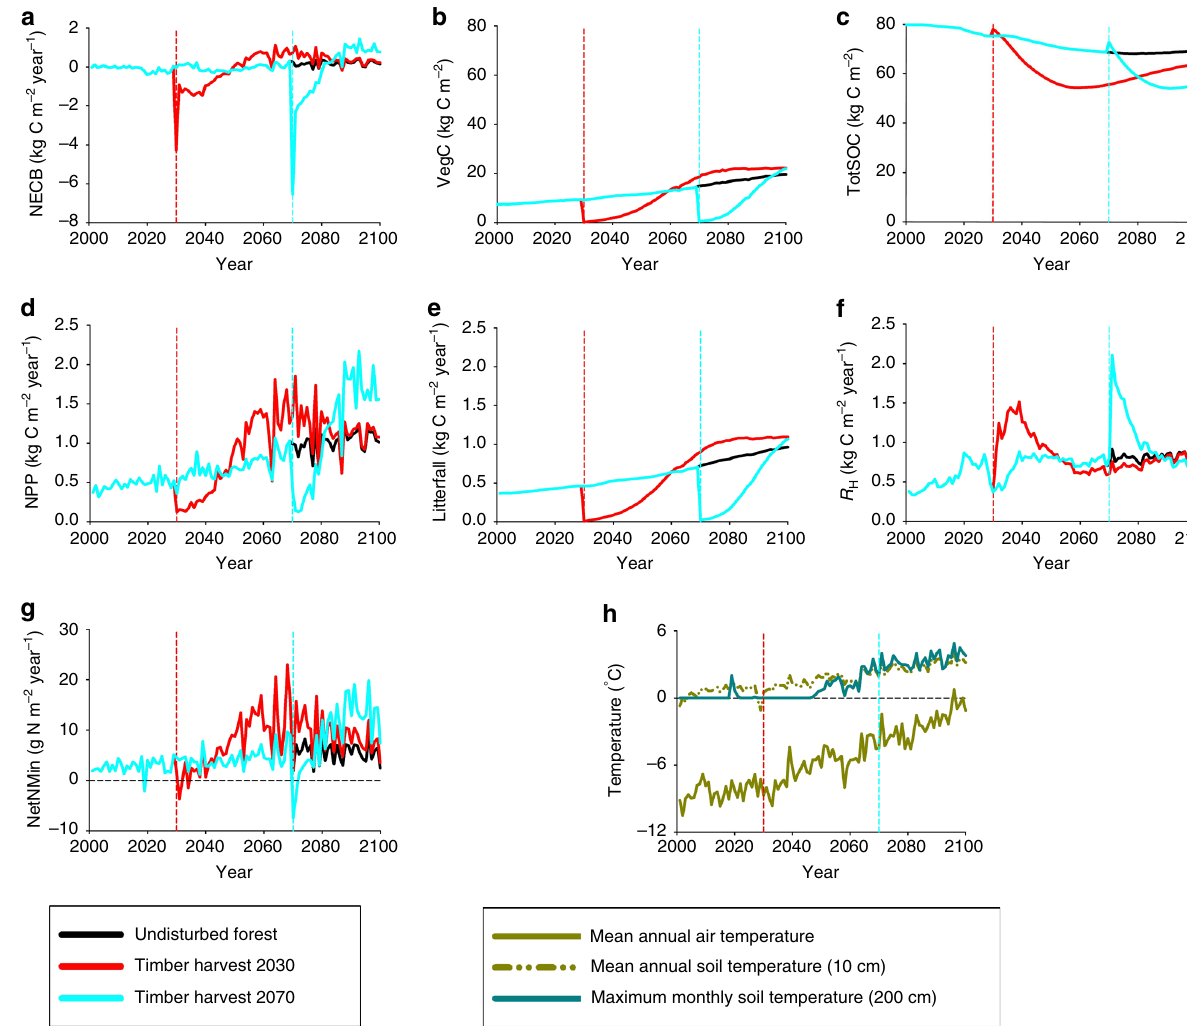
Fig. 9 In fl uence of climate change and timber harvest on C and N dynamics of a Siberian larch forest stand during the 21st century under the RCP8.5 scenario. a Net C sequestration represented by annual net ecosystem carbon balance (NECB). b Vegetation carbon stocks (VegC). c Total soil organic carbon (TotSOC) stocks. d Annual net primary production (NPP). e Annual litterfall carbon. f Annual heterotrophic respiration ( R H ). g Annual net N mineralization (NetNMin). h Mean annual air temperature, mean annual soil temperature at 10 cm depth, and maximum monthly soil temperature at 200 cm depth. Permafrost thaw is assumed to occur when the maximum monthly soil temperature at 200 cm depth increases above 0 o C. Timber harvests occurred either in the year 2030 (red lines) or 2070 (blue lines). Carbon and nitrogen dynamics of undisturbed forests (no timber harvest) are represented with the black